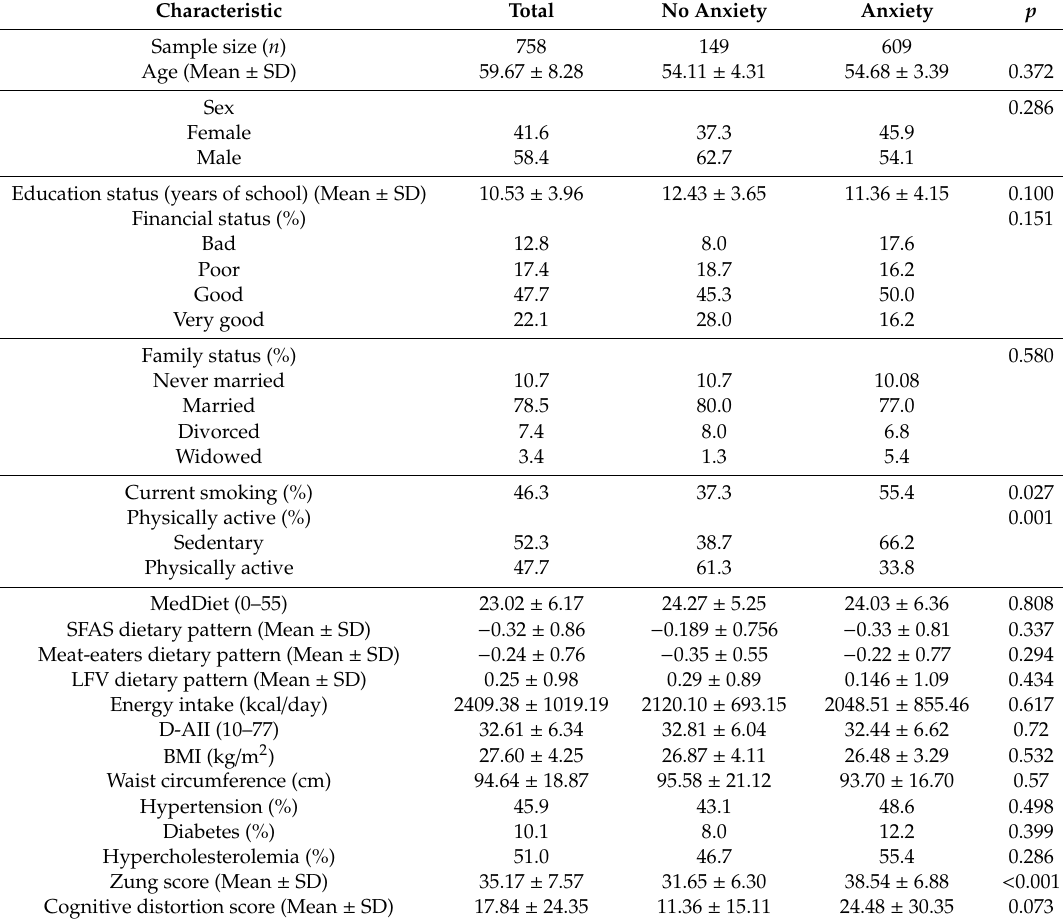
Table 2. Baseline characteristics of the study sample 50 + years old, by anxiety